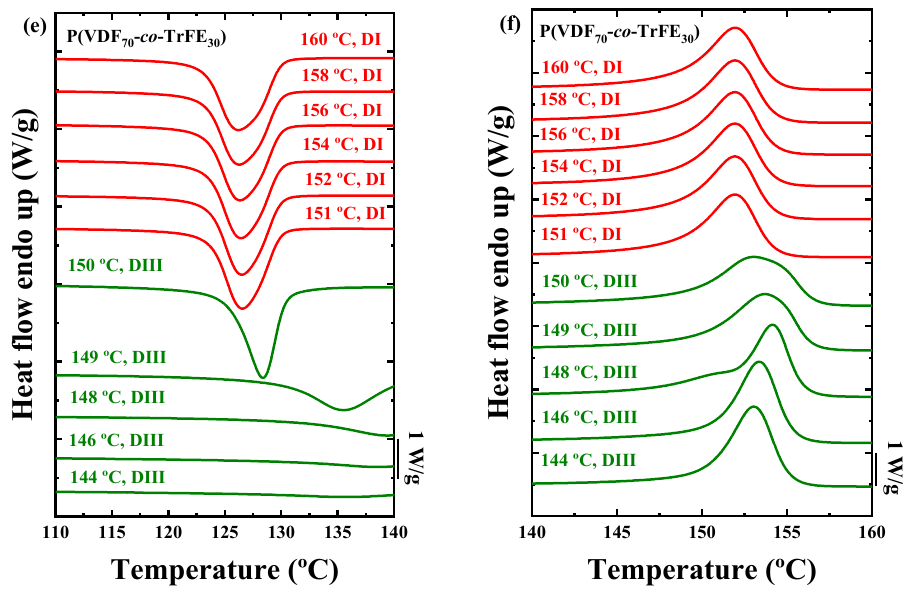
Figure 10. DSC cooling sweeps after 5 min at the indicated T s values for ( a ) PVDF 80 - co -TrFE 20 , ( c ) P(VDF 75 - co -TrFE 25 ) and ( e ) P(VDF 70 - co -TrFE 30 ) samples, and DSC heating scans after the cooling process for ( b ) P(VDF 80 - co -TrFE 20 ), ( d ) P(VDF 75 - co -TrFE 25 ), and ( f ) P(VDF 70 - co -TrFE 30 ) samples.